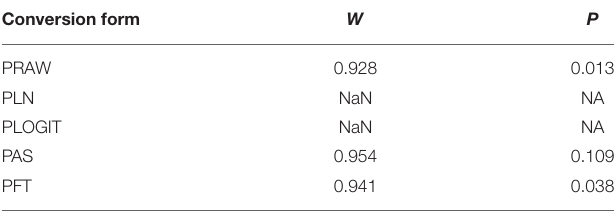
TABLE 2 | Normal distribution test for the normal rate and the different conversion of the normal rate.